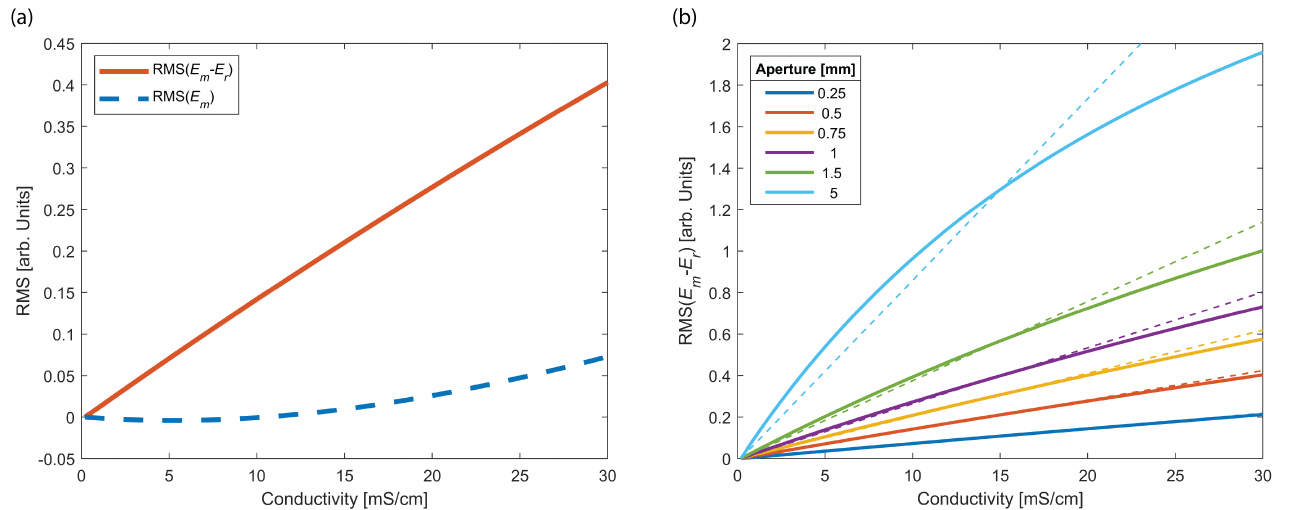
Figure 2. ( a ) Root mean square RMS( E m ) (dashed blue, shifted to start at zero) and RMS( E m − E r ) (orange) values as a function of the electrical conductivity σ f in the 0.5mm aperture fracture. A clear linear dependency for RMS( E m − E r ) can be seen. ( b ) RMS( E m − E r ) for different fracture apertures. For fractures within the sub-mm range, a quasi-linear dependency on σ f is visible. For comparison, a strictly linear dependency between the obtained values at 0 and at σ f = 5mS/cm is depicted as dashed lines. Note the different y-axis scale of both